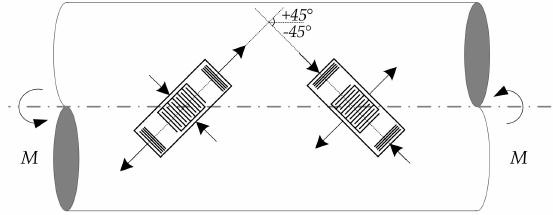
Figure 2. The schematic of the surface acoustic wave (SAW) torque sensor